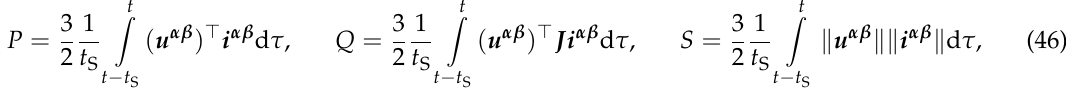
Figure 12. Pump curves of the simulated pump system with trajectories ( H p ( ( P p, m ( ) , Q P ( )) ( b ) of operating points taken from the simulation data shown in Figure · ·